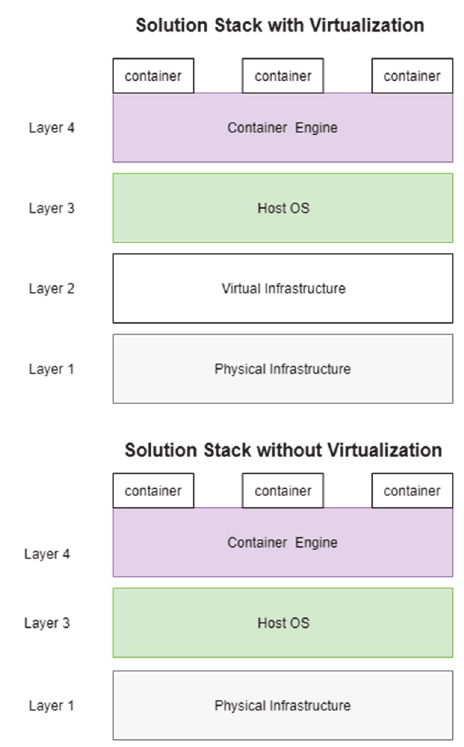
Fig. 2. Virtualization as an optional layer for the container solution